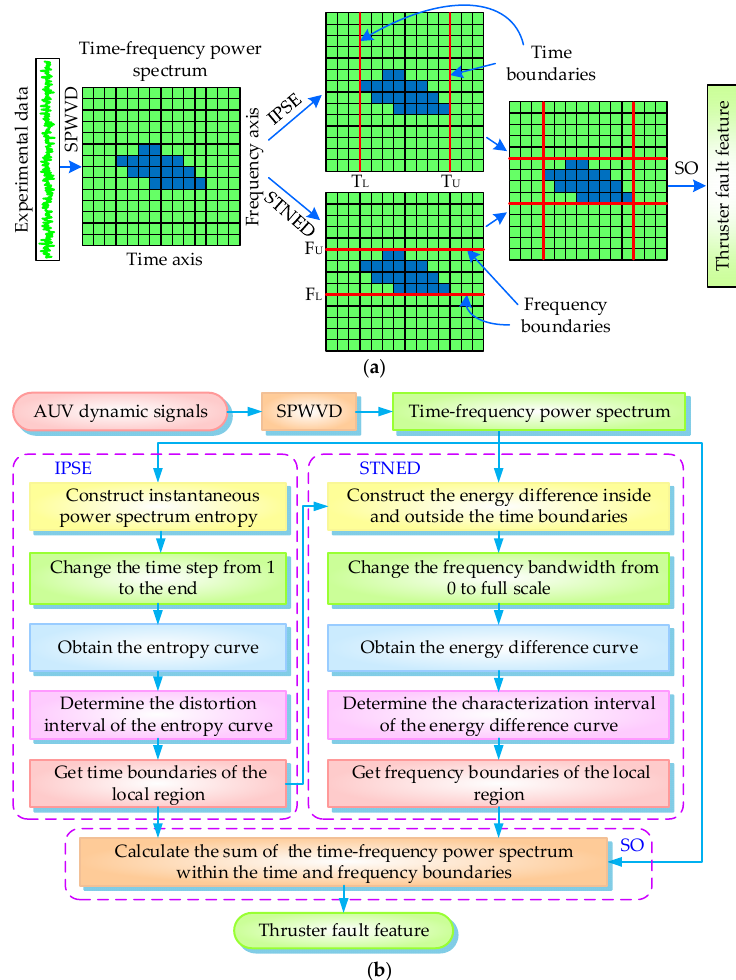
Figure 1. The flow chart of the proposed TFE: ( a ) The schematic diagram; ( b ) The framework dia- gram. As shown in Figure 1, the time-frequency power spectrums of AUV dynamic signals are obtained based on SPWVD. The thruster fault causes the energy to migrate to a local region. The IPSE is proposed to identify the time boundaries of the local region. The STNED is developed to get frequency boundaries of the local region. These are two new contents added by the TFE, while these don’t exist in conventional SPWVD. The TFE cal- culates the sum of the time-frequency power spectrum enclosed by the time and frequency boundaries, while conventional SPWVD adds up the entire time-frequency power spec- trum or the time-frequency power spectrum larger than the threshold value. The process of the proposed TFE is described in detail in the followings. (1) The IPSE-based time boundary identification The schematic diagram of the proposed IPSE is shown in Figure 2. The basic idea of the IPSE is described as follows. Thruster fault produces a local concentration in the time- frequency power spectrum. The concentration promotes a signal energy migration from high frequencies to low frequencies. The energy distribution of the instantaneous power spectrum becomes uneven. The Shannon entropy of the instantaneous power spectrum decreases. It forms a distortion interval in the entropy curve, which is contributed by the Shannon entropy at each moment. The interval boundaries are regarded as time bounda- ries of the local region.